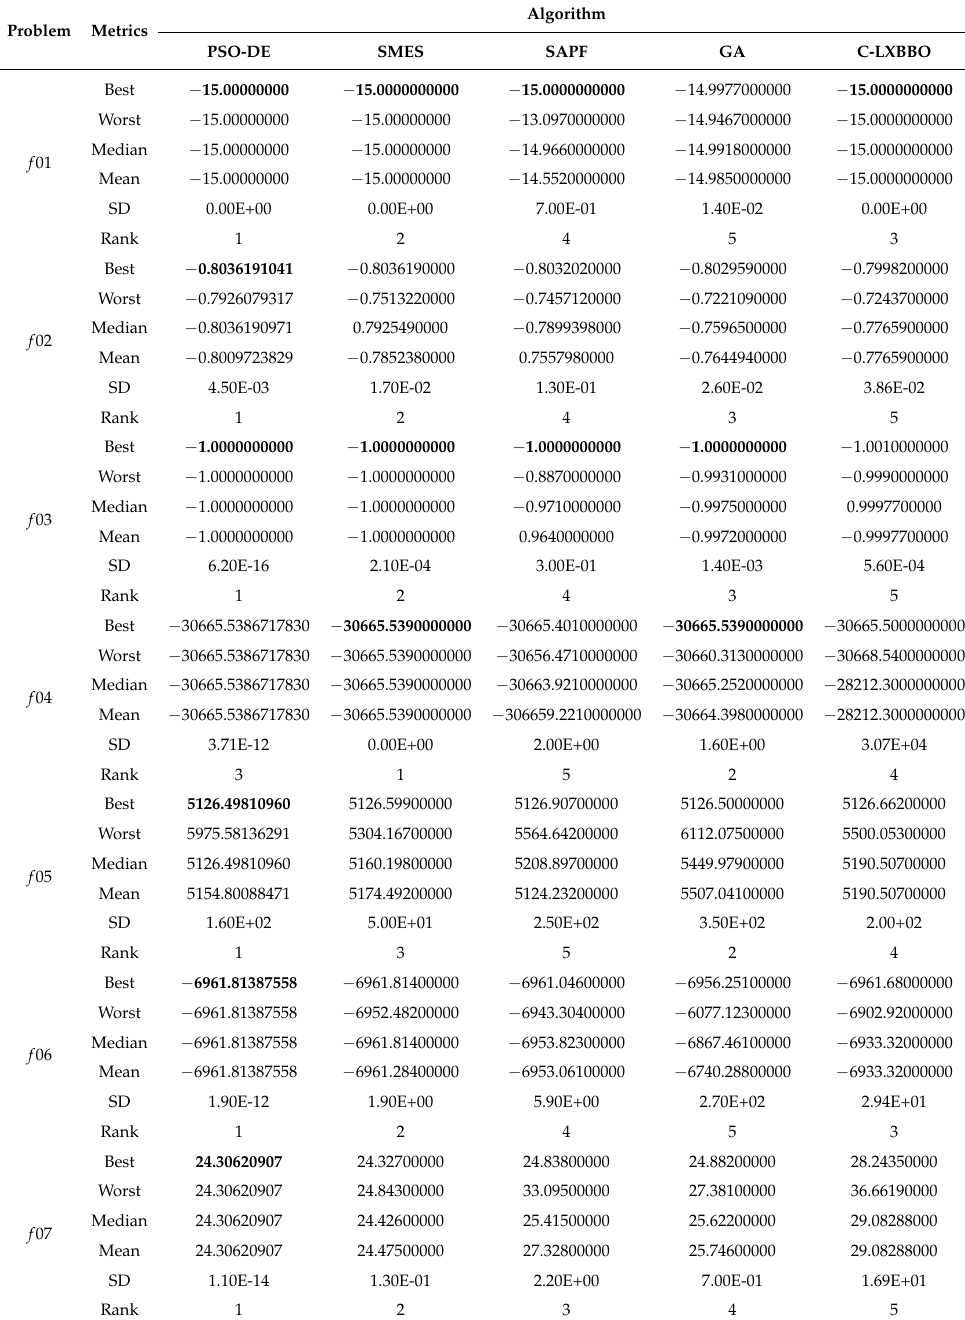
Table 5. The results of PSO-DE compared with other algorithms in the benchmark